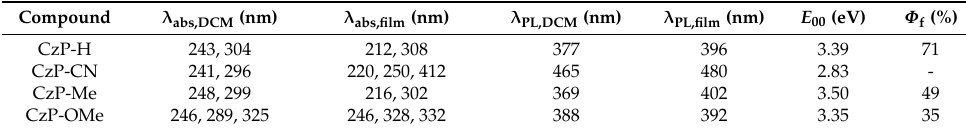
Figure 3. ( a ) Ultraviolet-visible and ( b ) PL spectra of CzP-H, CzP-CN, CzP-Me, and CzP-OMe in DCM solvent; ( c ) Ultraviolet-visible and ( d ) PL spectra of CzP-H, CzP-CN, CzP-Me, and CzP-OMe in films. Table 2. Photophysical properties of the